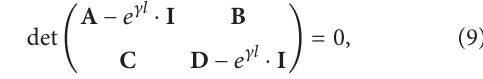
Figure 2: Layout (a) and electromagnetic response (b) of an SRR-loaded CPW unit cell. The considered substrate throughout this paper is Rogers RO3010 with dielectric constant 𝜀 𝑟 = 11.2 and thickness ℎ = 1.27 mm. CPW dimensions are central strip width 𝑊 = 8 mm, width of the slots 𝐺 = 1.43 mm, and length of the line 𝑙 = 8 mm. SRR dimensions are outer ring width 𝑐 distance between the rings 𝑑 = 0.24 mm, and internal radius 𝑟 = 2.69 mm. The extracted circuit parameters are 𝐿 󸀠 = 1.91 nH, 𝐶 = 2.07 pF, = 0.24 nH, and 𝐶 󸀠 = 23.01 pF. From [33], reprinted with 𝐿 󸀠 𝑠 𝑠